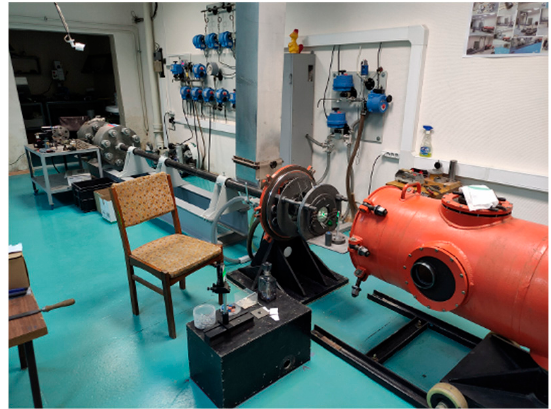
Figure 3. Gas gun for investigating shock-wave phenomena in solids.